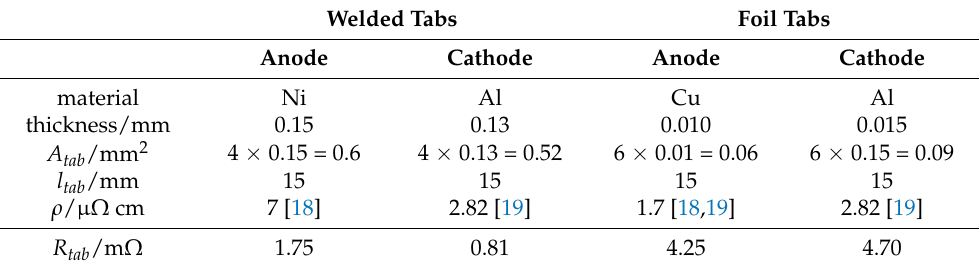
Table 1. Resistance calculation for different types of tabs for the tab volume from the border of the coated electrode area to the end of the tab (see step 4a in Figure 2). Welded Tabs Foil Tabs Anode Cathode Anode Cathode